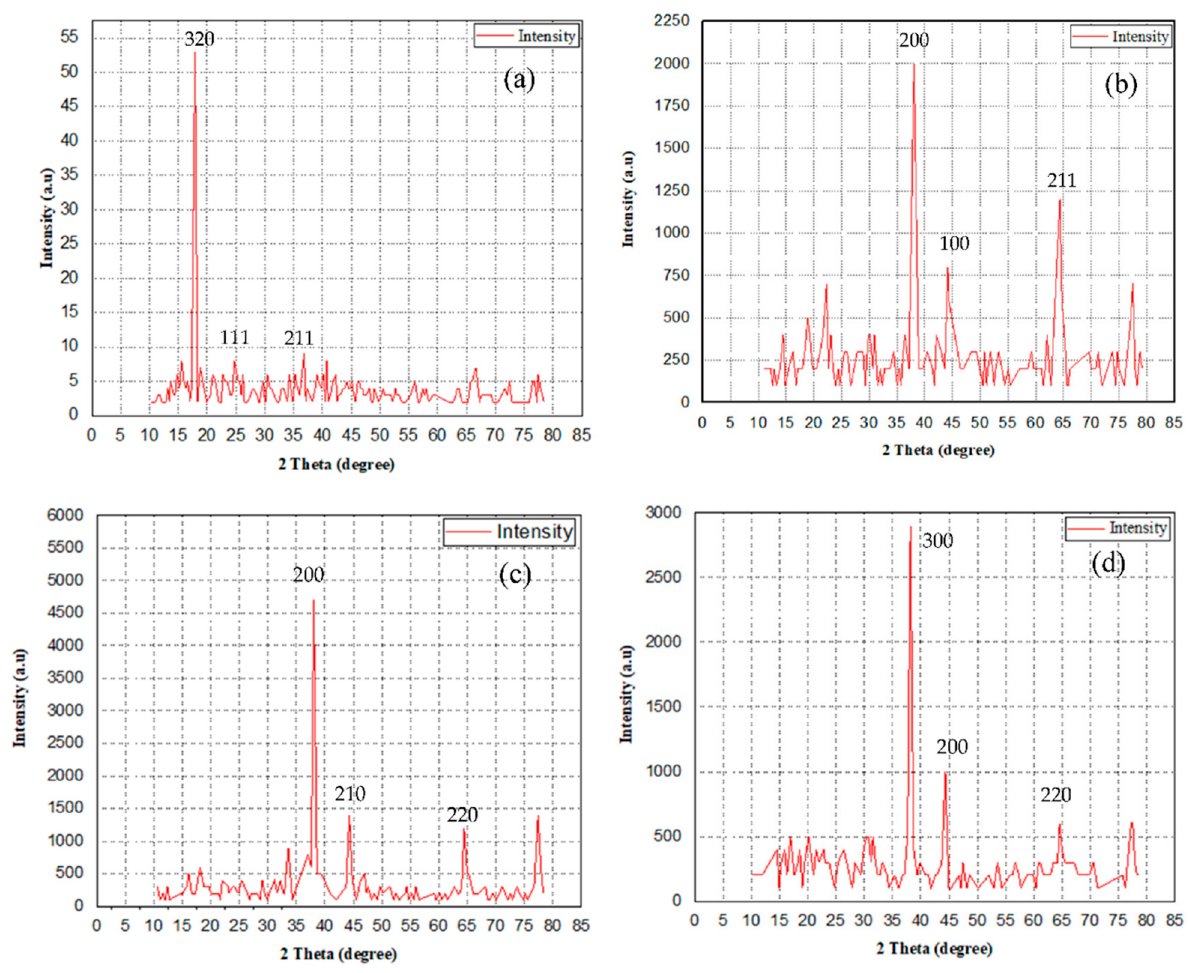
Figure 4. XRD patterns—( a ) Nafion, ( b ) Nafion + Ag, ( c ) Nafion + Ag + CNT and ( d ) Nafion + Ag + Graphene.